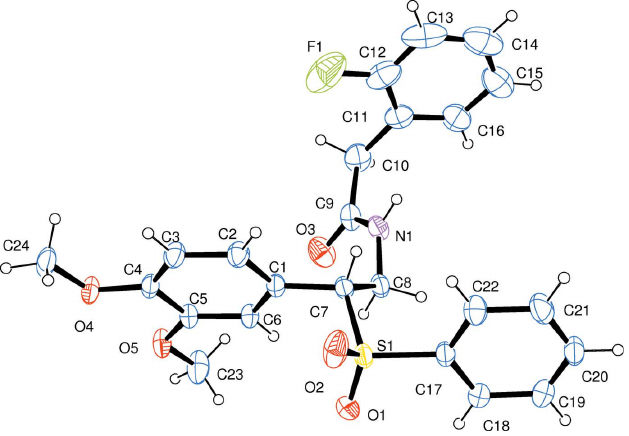
Figure 2 The molecular structure of the title compound with displacement ellipsoids drawn at the 30% probability level.